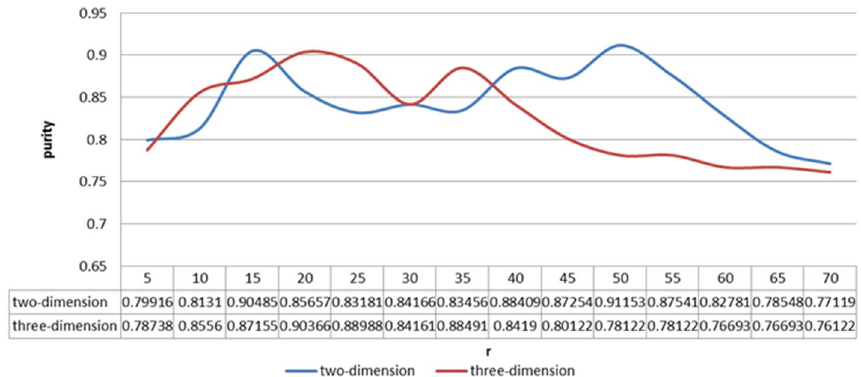
Fig. 20 Effect of r on clustering purity. The blue curve depicts the effect of radius changes on purity in two‑dimensional space, while the red curve depicts the effect of radius changeson purity in three‑dimensional